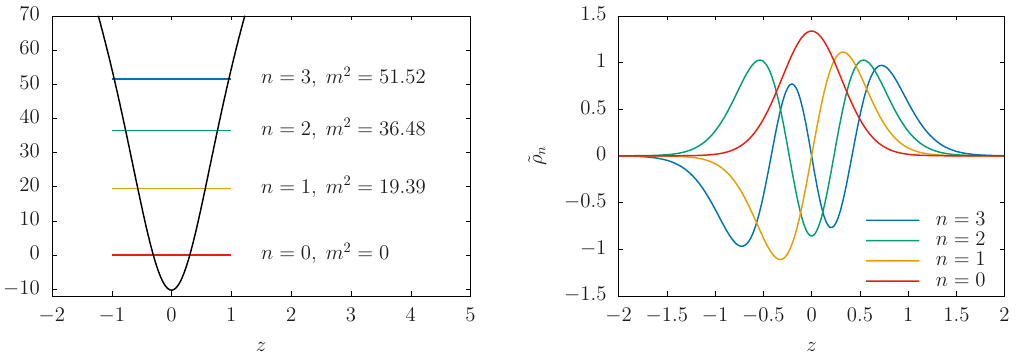
− Figure 3 . In the left (cid:12)gure, the black line represents the potential V III ( z ), and colored lines represent the position of mass spectra in the potential. The right (cid:12)gure shows the corresponding solutions of ~ (cid:26) n (nomalized). Parameters C 3 = 0 : 6 ; C 2 = 20, and k =